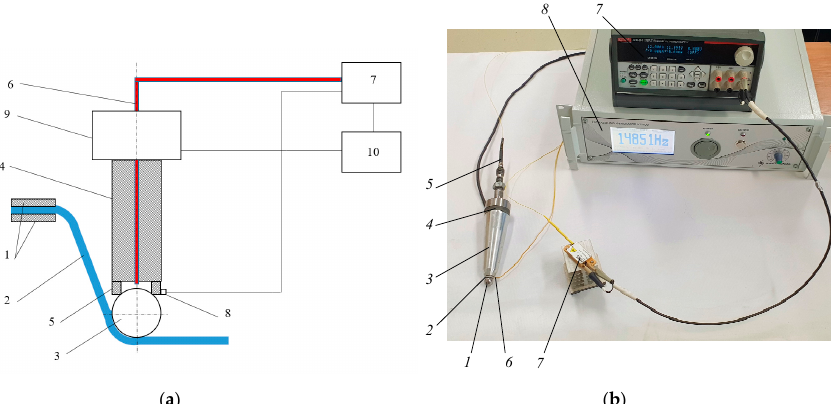
Figure 15. Polymer sheet SPIF with a laser heating: ( a ) schematics; ( b ) equipment: 1—metal sphere; 2—ring-shaped magnet; 3—waveguide; 4—ultrasonic vibration transducer-piezoceramic discs; 5—fiber optics; 6—temperature sensor, 7—laser diode module BMU25-940-01-R (Oclaro Inc., San Jose, CA, USA) with laser beam intensity controller Keithley 2230-30-1 (Keithley Instruments Inc., Cleveland, OH, USA), 8—ultrasonic vibration controller Sensotronica VT-400. (KTU, Kaunas, Lithuania).